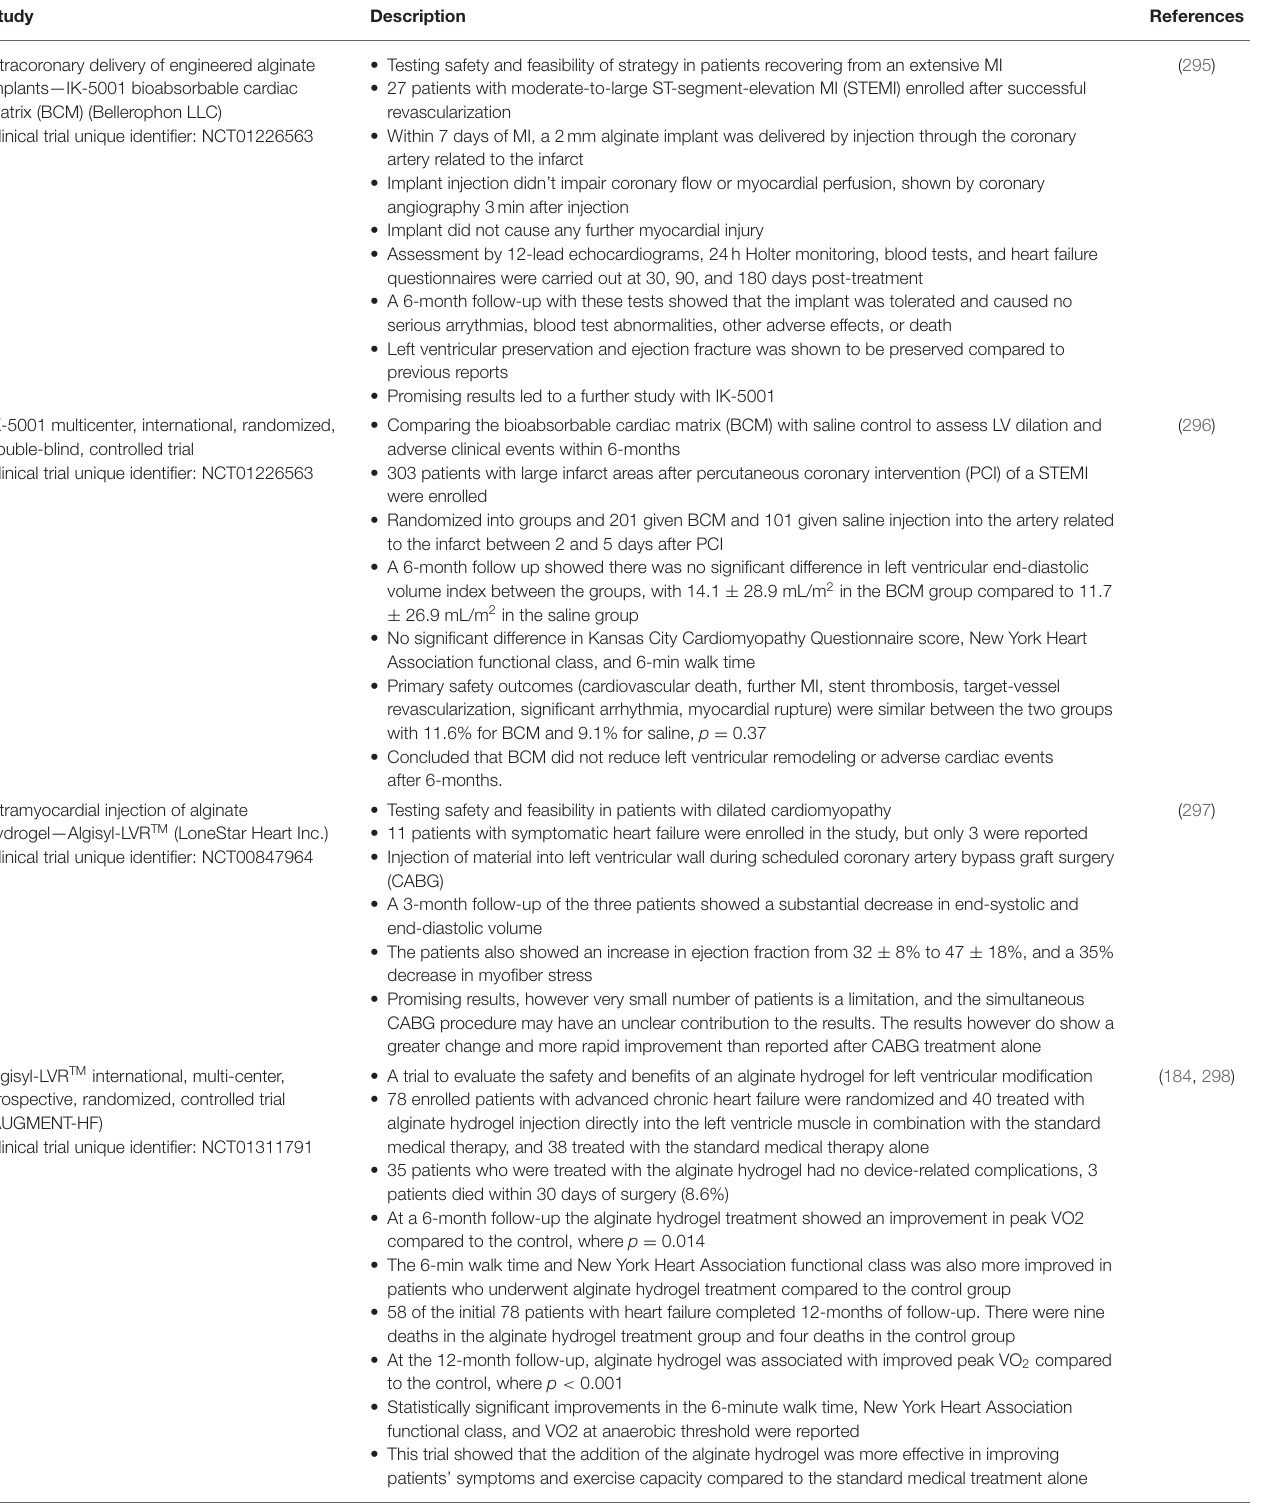
TABLE 2 | Clinical trials using natural biomaterials in cardiac repair.